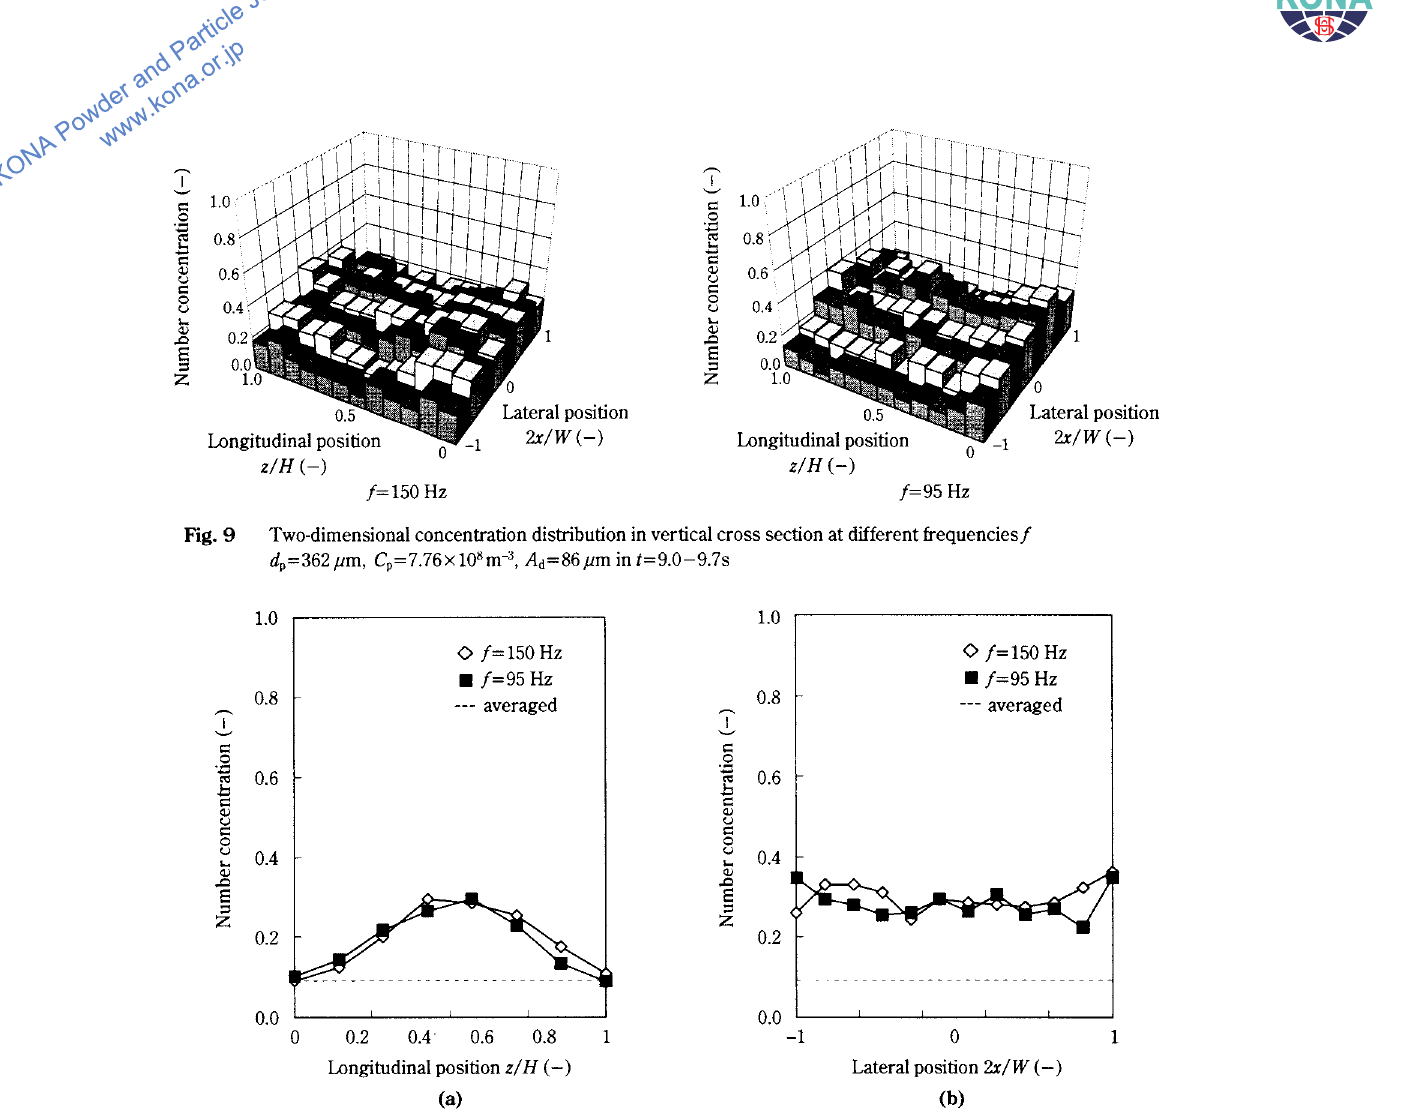
Fig. 10 Effect of frequency f (a) on longitudinal particle concentration distribution at lateral position 0.38-0.63, (b) on lateral particle concentration distribution at longitudinal position 0.42-0.58: dp=362 f.im, f= 150Hz, Cp=7.76x 10 8 m- 3